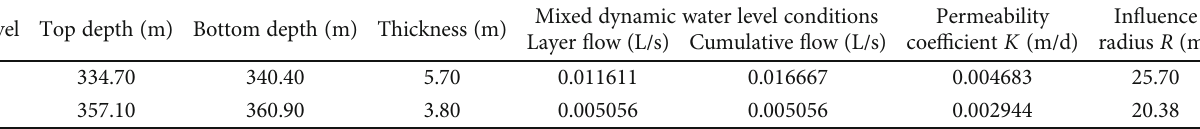
Table 4: Auxiliary shaft aquifer